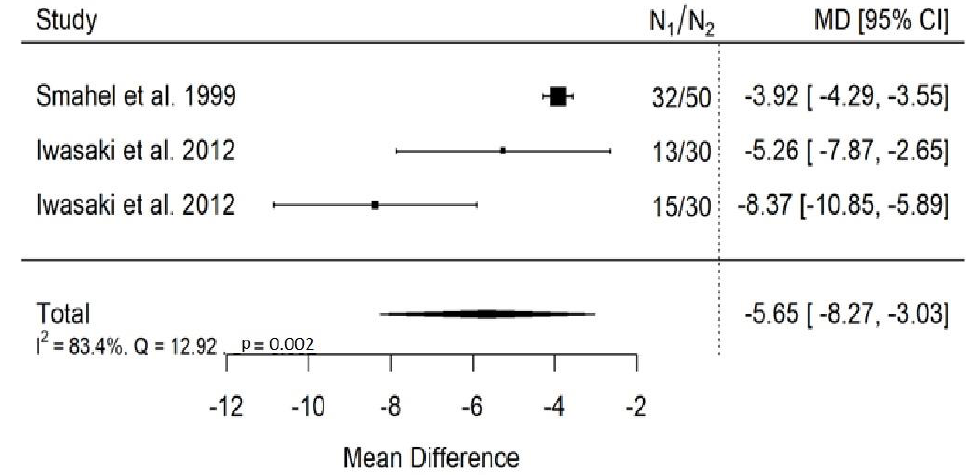
Figure 14. Forest plot of SNA values for the comparison of patients with submucous cleft palate treated surgically and orthodontically vs. non-cleft healthy population [26,32].